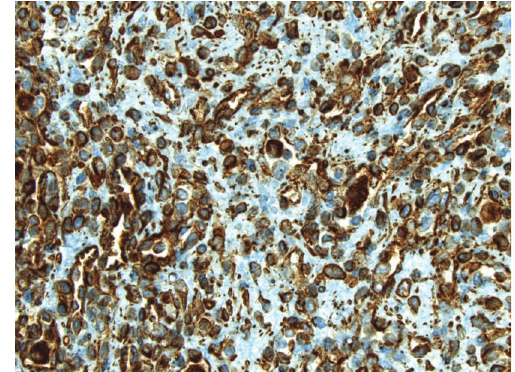
Figure 5: Vimentin immunostain highlights most of the tumor cells strongly (DAB chromogen, high